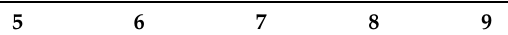
Table 4. Bivariate correlations among study